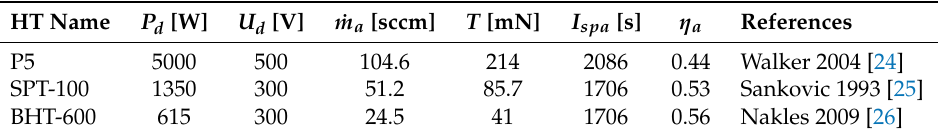
Table 2. Example of mid- and high-power Hall thruster performances, operated with xenon at nominal operating